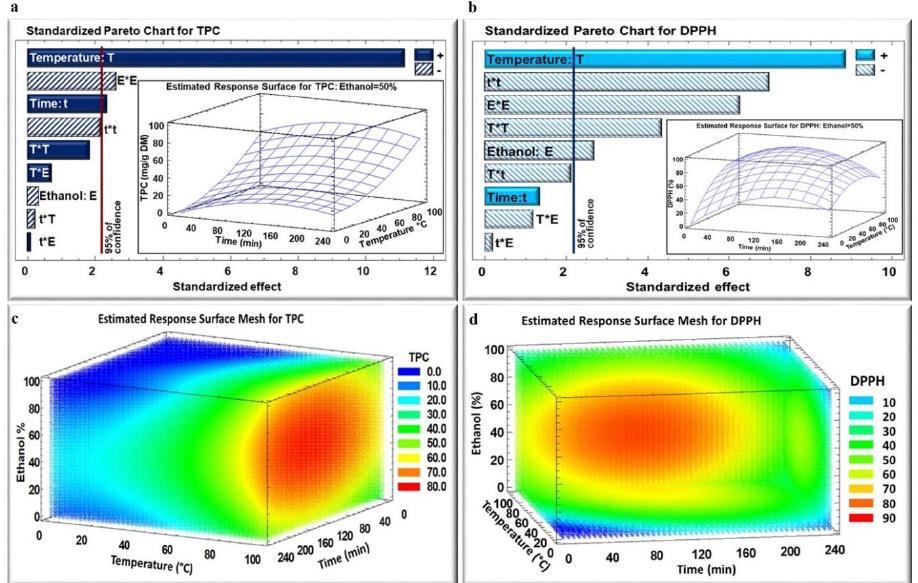
Figure 1. Standardized Pareto Chart for TPC ( a ) and DPPH ( b ) inhibition percentage for IR extraction, and estimated response surface Mesh for TPC ( c ) and DPPH ( d ) inhibition percentage. (+) indicates positive effect, ( − ) indicates negative effect.